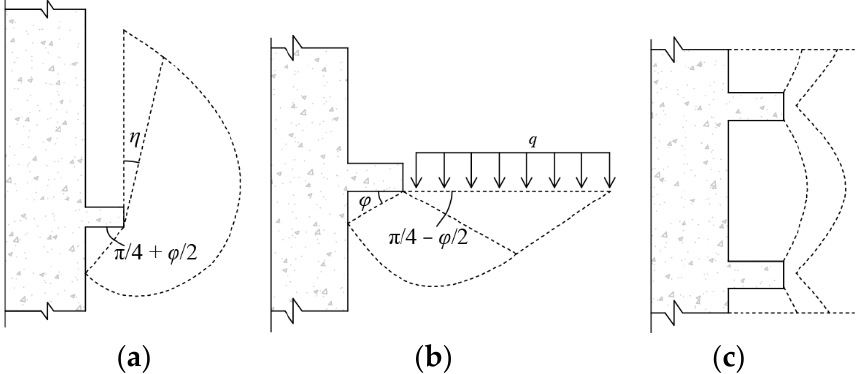
Figure 11. Theoretical assumptions of the failure mode under the screw teeth. ( a ) Meyerhof, ( b ) Terzaghi, and ( c ) arch